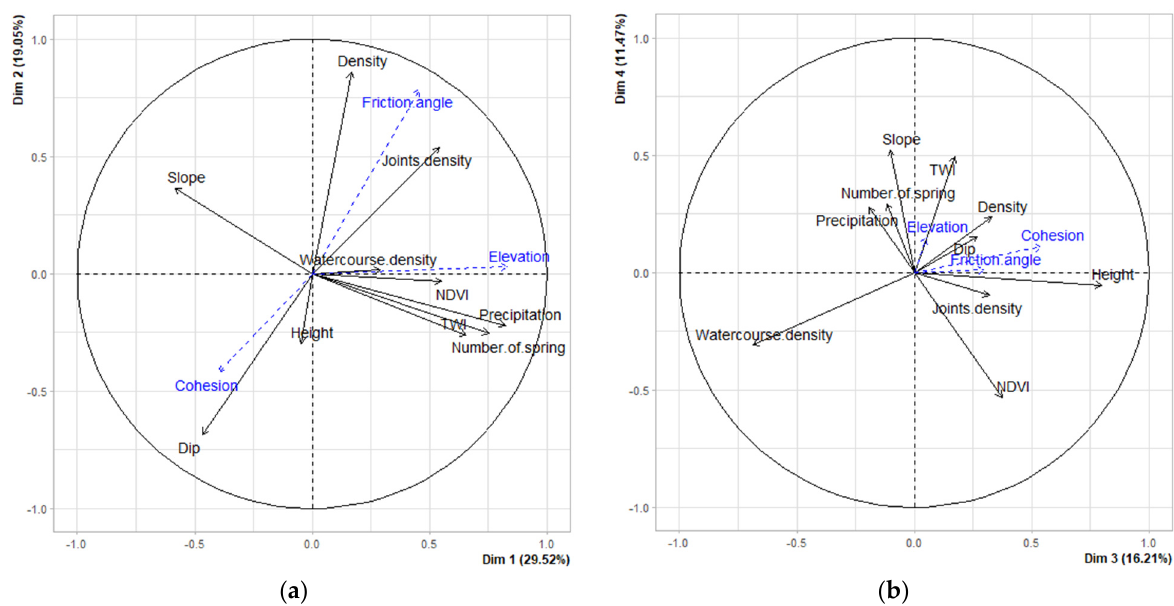
Figure 11. Correlation variables circle, landslide PCA. Along ( a ) axis 1 and 2; ( b ) axis 3 and 4.